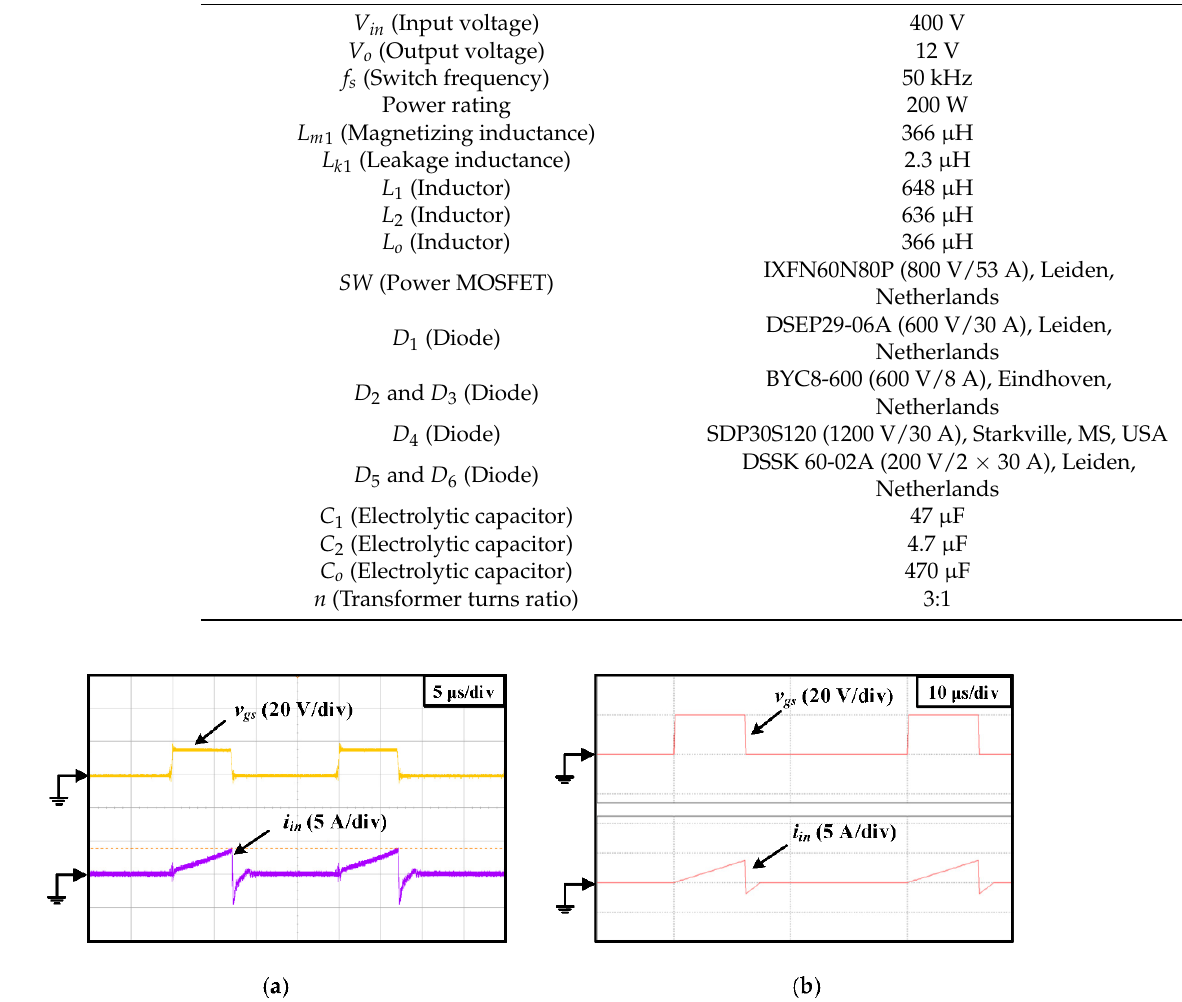
Table 2. Parameters and components used in the prototype.